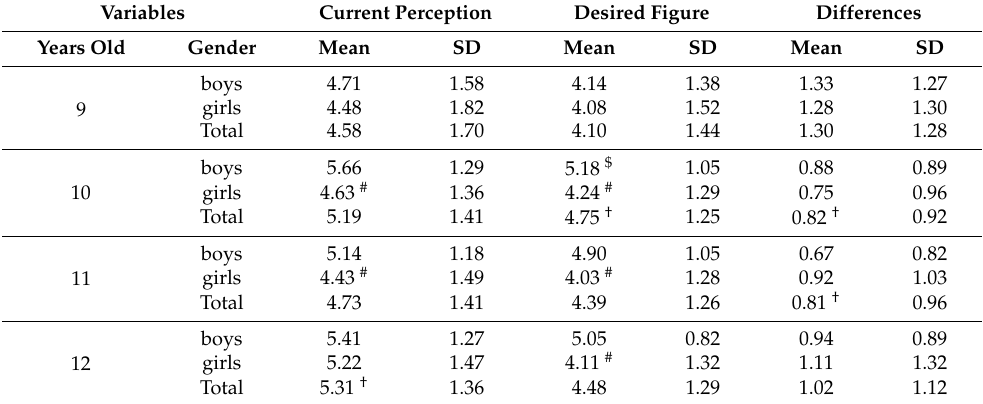
Table 2. Current figure and desired figure and differences between them based on gender and